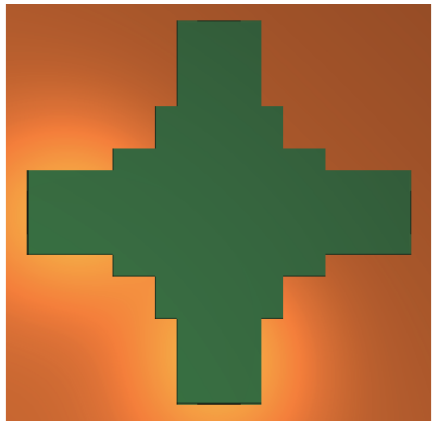
Figure 2: Aperture